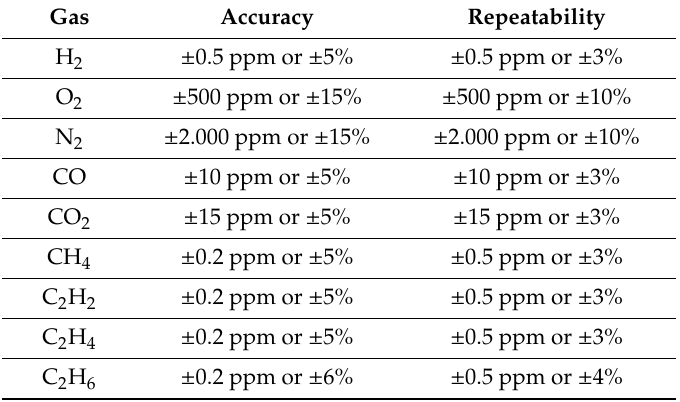
Table 7. Accuracy and repeatability details of the individual